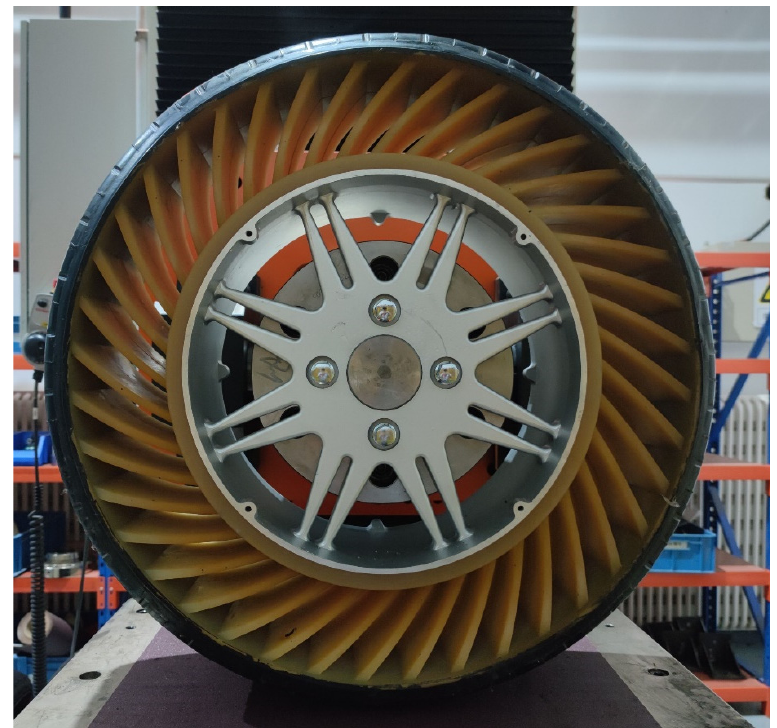
Figure 5. A sample of the FS-NPT. The test experiment used the static loading method. A vertical downward load was imposed on the center of the hub. The wheel deformation was recorded during the continuous loading process. Then the relationship between vertical load and vertical movement of the hub was obtained. Figure 6 shows the course of the center lines of the vertical stiffness for a normal load of 2800 N, which were obtained during the FEA model and experimental research. Figures 7 and 8 show both simulation and test results of the lateral stiffness and longitudinal stiffness under a normal load of 2800 N, respectively. There may be four reasons for the differences between the obtained characteristics: using material data from the literature for the tread rubber and steel belt, disregarding the Mullins effect in the material model, neglecting the defects in the manufacturing process, and omitting the tread’s